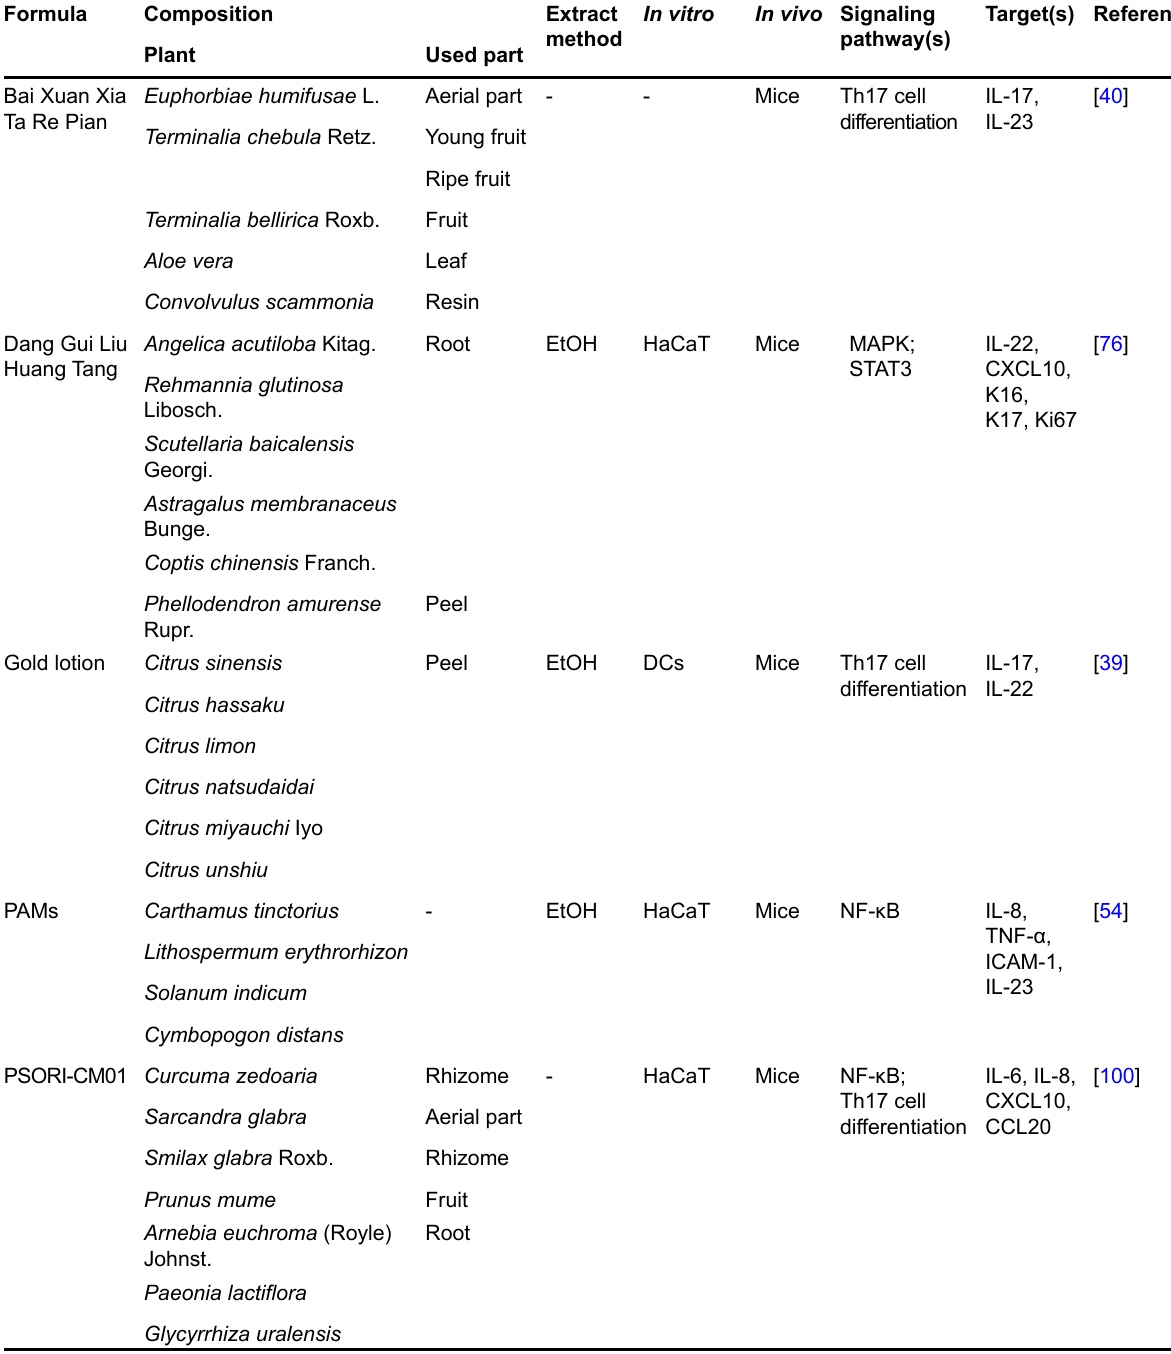
Table 3. The effects of herbal formulas on psoriasis